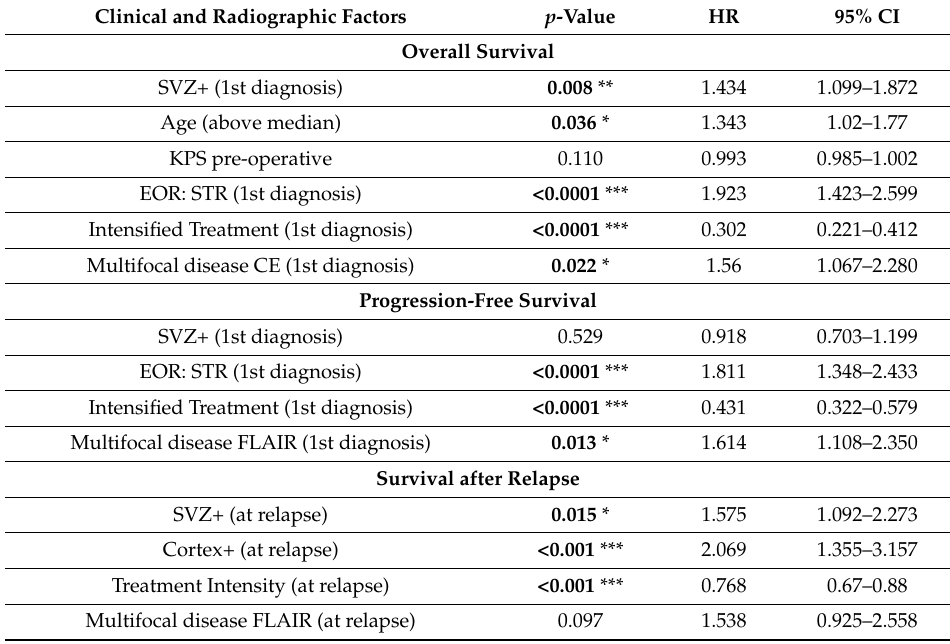
Table 2. Multivariate Analysis of Overall Survival ( n = 253), Progression-free Survival ( n = 253), and Survival after Relapse ( n = 150) for the Complete IDH1-Wildtype Cohort.